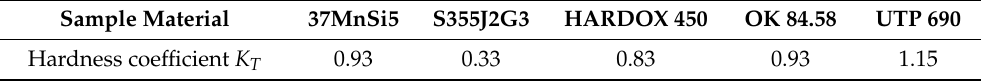
Table 7. Hardness coefficient values K T